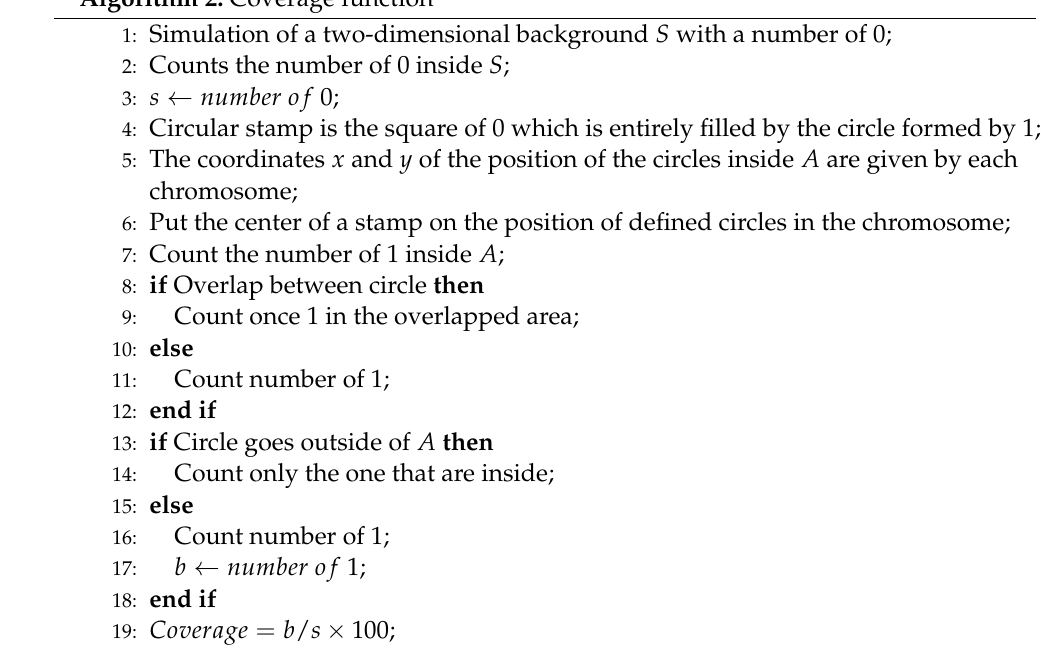
Algorithm 2: Coverage